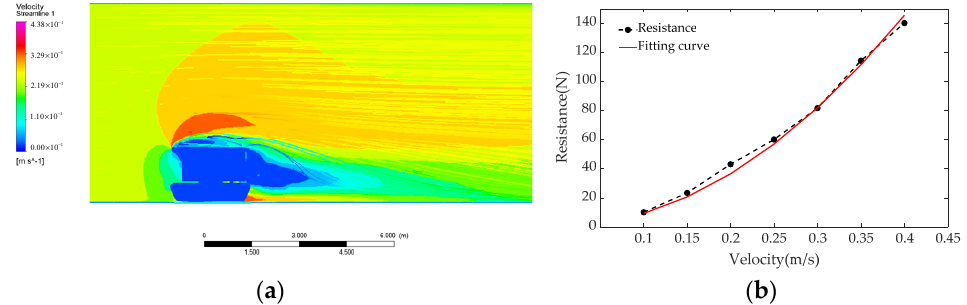
Figure 8. Hydrodynamic resistance calculation results: ( a ) Velocity nephogram of DSLV at v c = 0.25 m/s; ( b ) Curve in hydrodynamic resistances versus velocity.